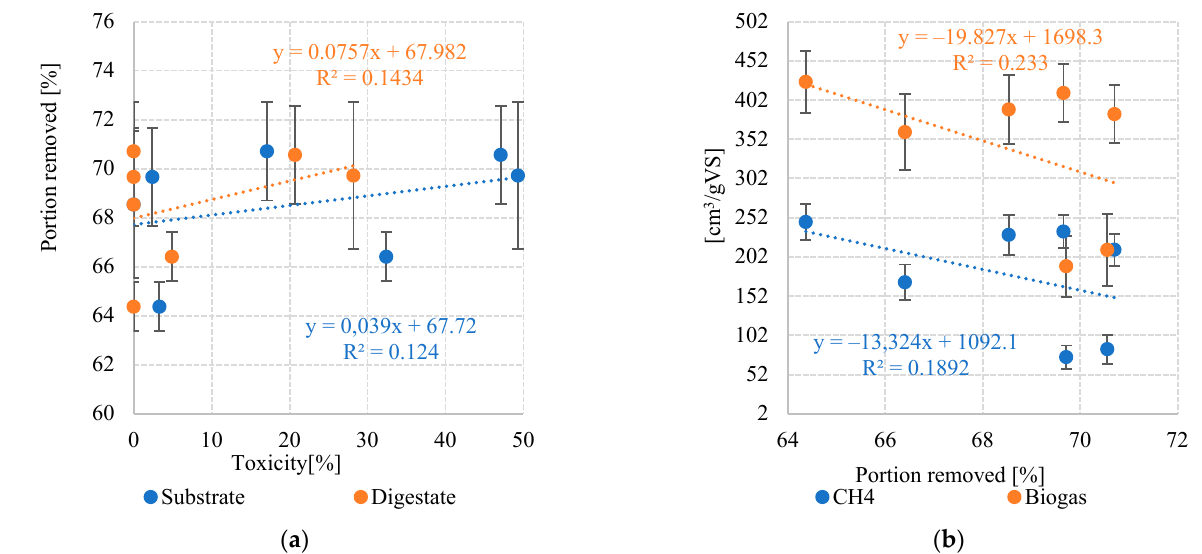
Figure 5. Correlations between ( a ) toxicity and portion digested, ( b ) portion digested and specific biogas/CH 4 production.